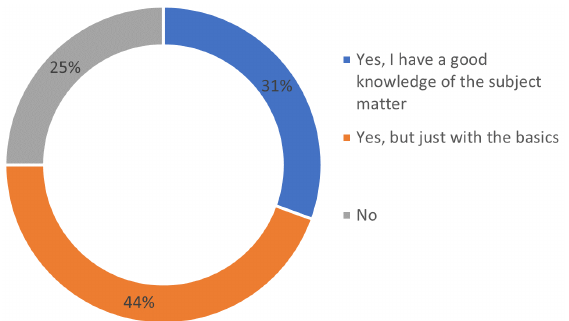
Figure 4. Responses to the question: Are you familiar with environmental LCA of construction products and buildings? (based on 72